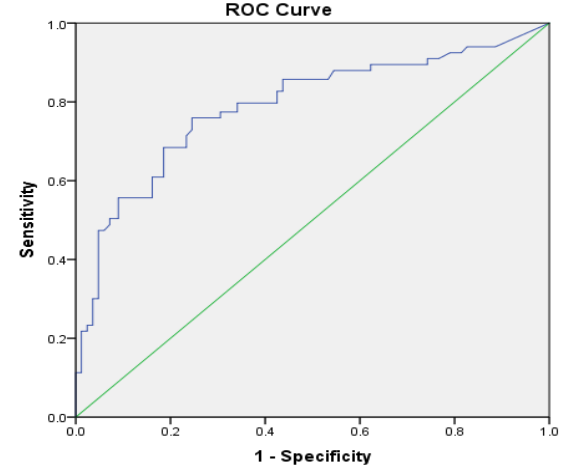
Figure 1. Area under the receiver operating characteristic (ROC) curve of proBNP in differentiating cardiogenic and non-cardiogenic syncope ( P <